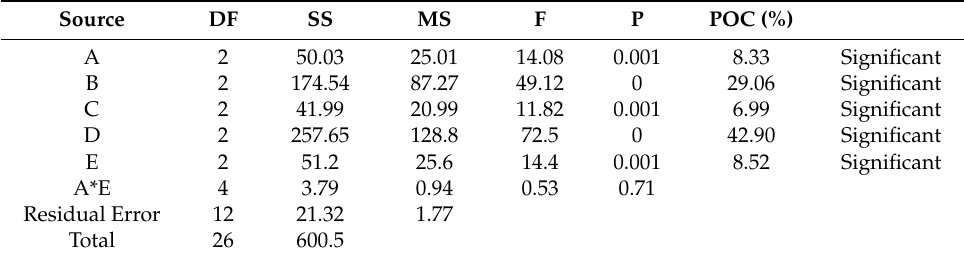
Table 6. Signal-to-noise ratio analysis for Surface